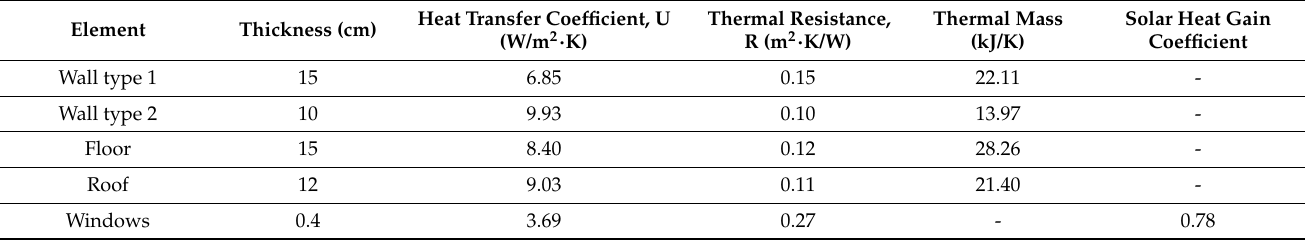
Table 2. Thermal variables of building’s